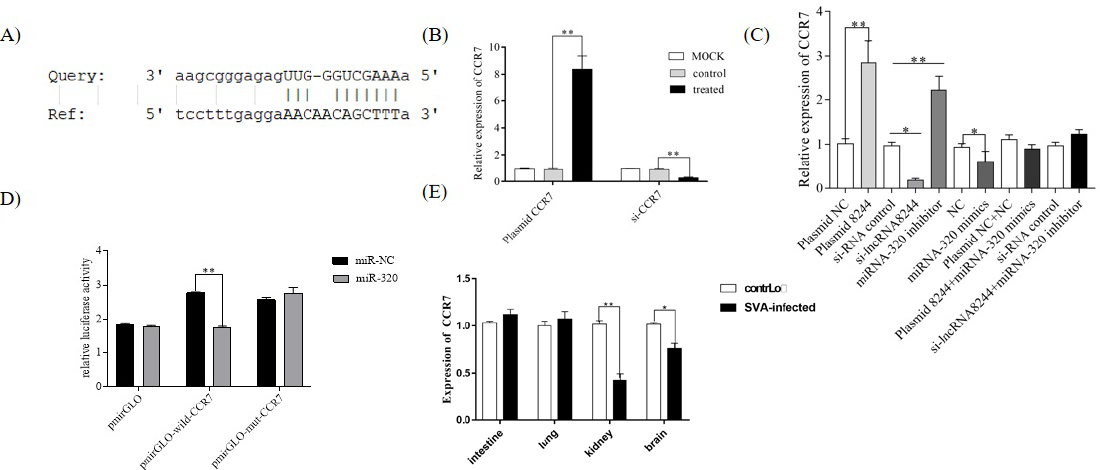
Figure 7. CCR7 is the target gene of miR-320. ( A ) Predicted binding sites for CCR7 on the miR-320. ( B ) PK-15 cells were treated with plasmid NC/plasmid CCR7/iNC/si-CCR7 for 24 h. The expression of CCR7 was determined by real-time RT-PCR assay and the mRNA level of CCR7 was normalized to the mRNA level of GAPDH. ( C ) The expression level of CCR7 was determined by real-time RT-PCR assay and the mRNA level of CCR7 was normalized to the mRNA level of GAPDH. ( D ) Luciferase activity in PK-15 cells co-transfected with luciferase reporter containing CCR7 or mutant and the mimics of miR-320. Data are presented as the relative ratio of Renilla luciferase activity and firefly luciferase activity. ( E ) Expression of CCR7 in clinical samples of SVA-infected piglets. Total RNA was extracted to determine the relative mRNA expression of CCR7 by real-time RT-PCR assay. All data are represented as mean ± SD with three replicates. * p < 0.05; ** p < 0.01.